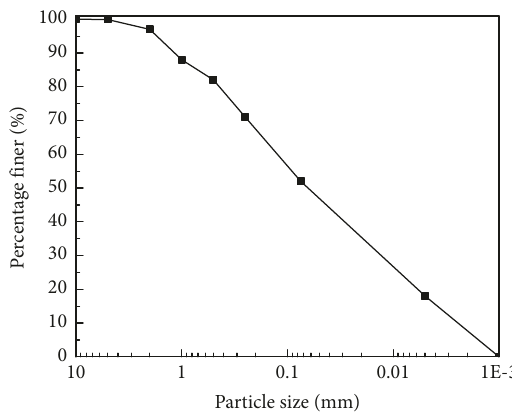
Figure 1: Particle-size distribution curve of the